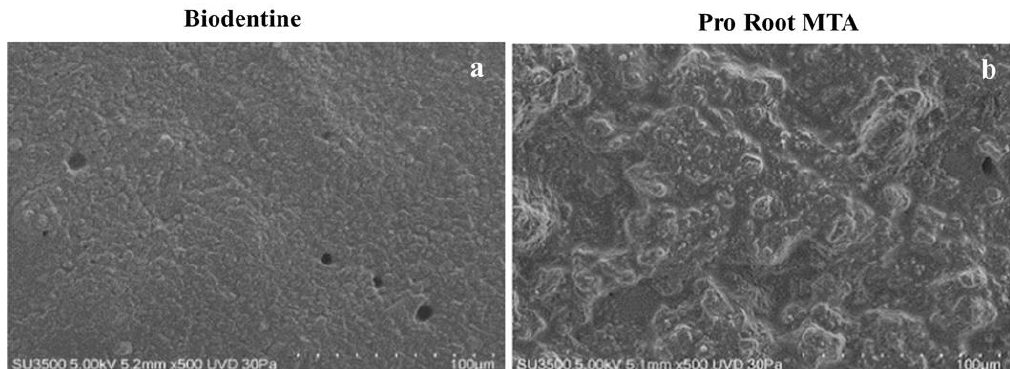
Figure 1. Morphological images of Biodentine and ProRoot MTA disks. ( a ) The surface of the Biodentine sample was smooth and plane, showing a fine and uniform granularity. The pores had a regular circular or elliptical shape. Magnification 500×. ( b ) In the ProRoot MTA sample, it was possible to observe a roughly irregular surface, with prominent aggregates separated by irregularly shaped depressions. The rare scattered pores had an irregular shape. Magnification 500×.